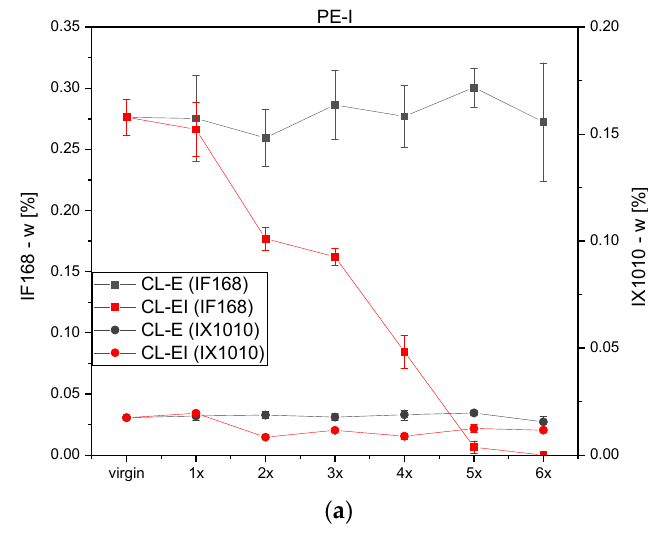
0.20 Figure 4. Cont